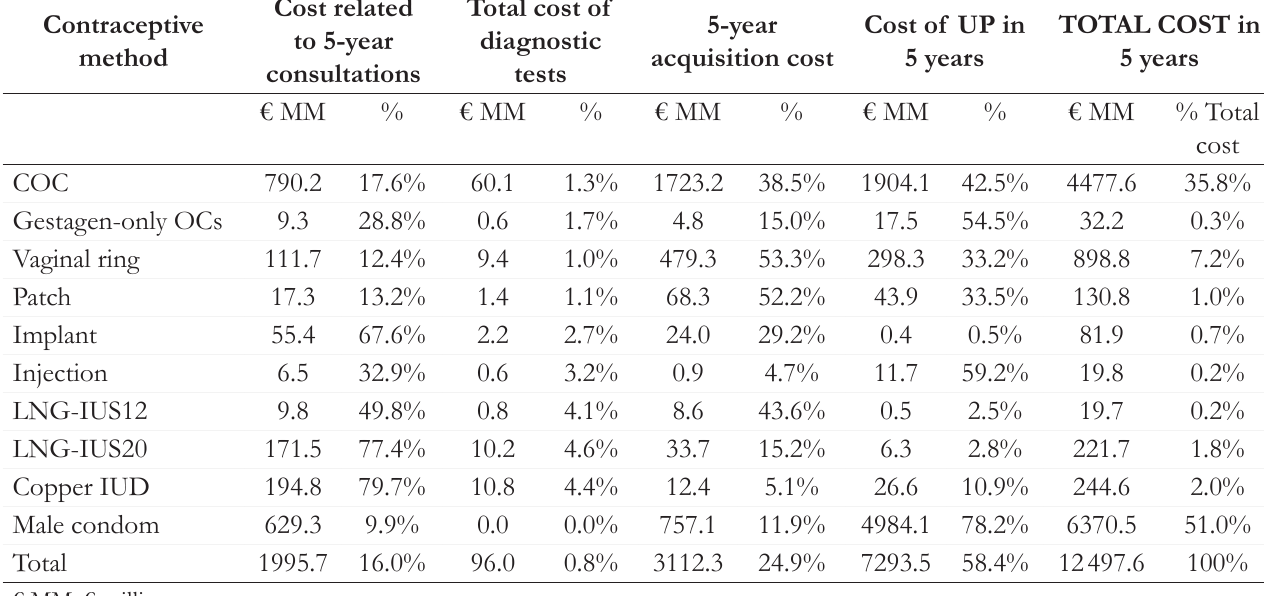
Table 7. Total Cost Associated to Reversible Contraception in a Period of 5 Years